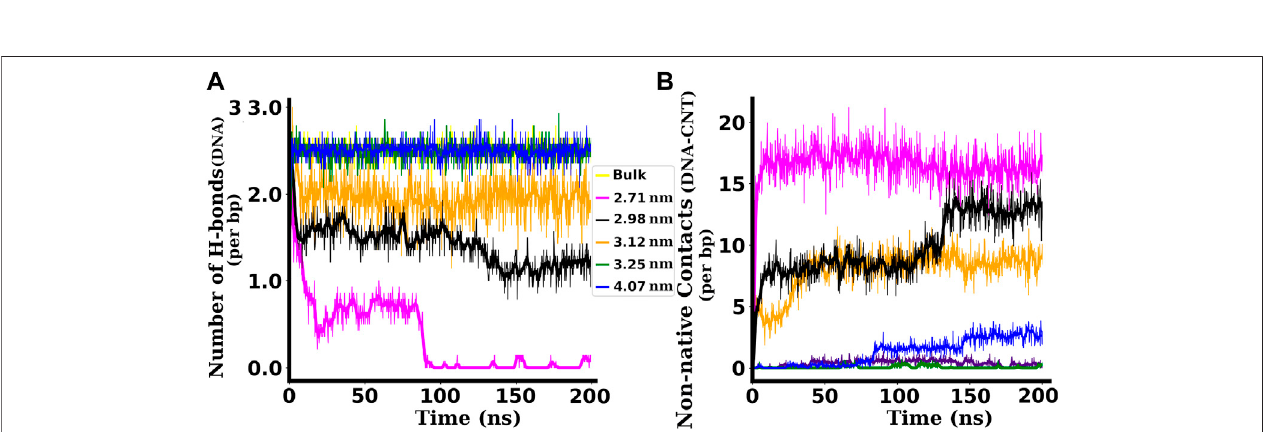
diameter3.12 nmandbelow,thenumberofH-bondsisfoundtobehighlyreducedandthenumberofnon-nativecontactsbetweenthedsDNAandtheSWCNTishighly increased. For the non-native contacts the distance cut-off of 3 Å is taken.